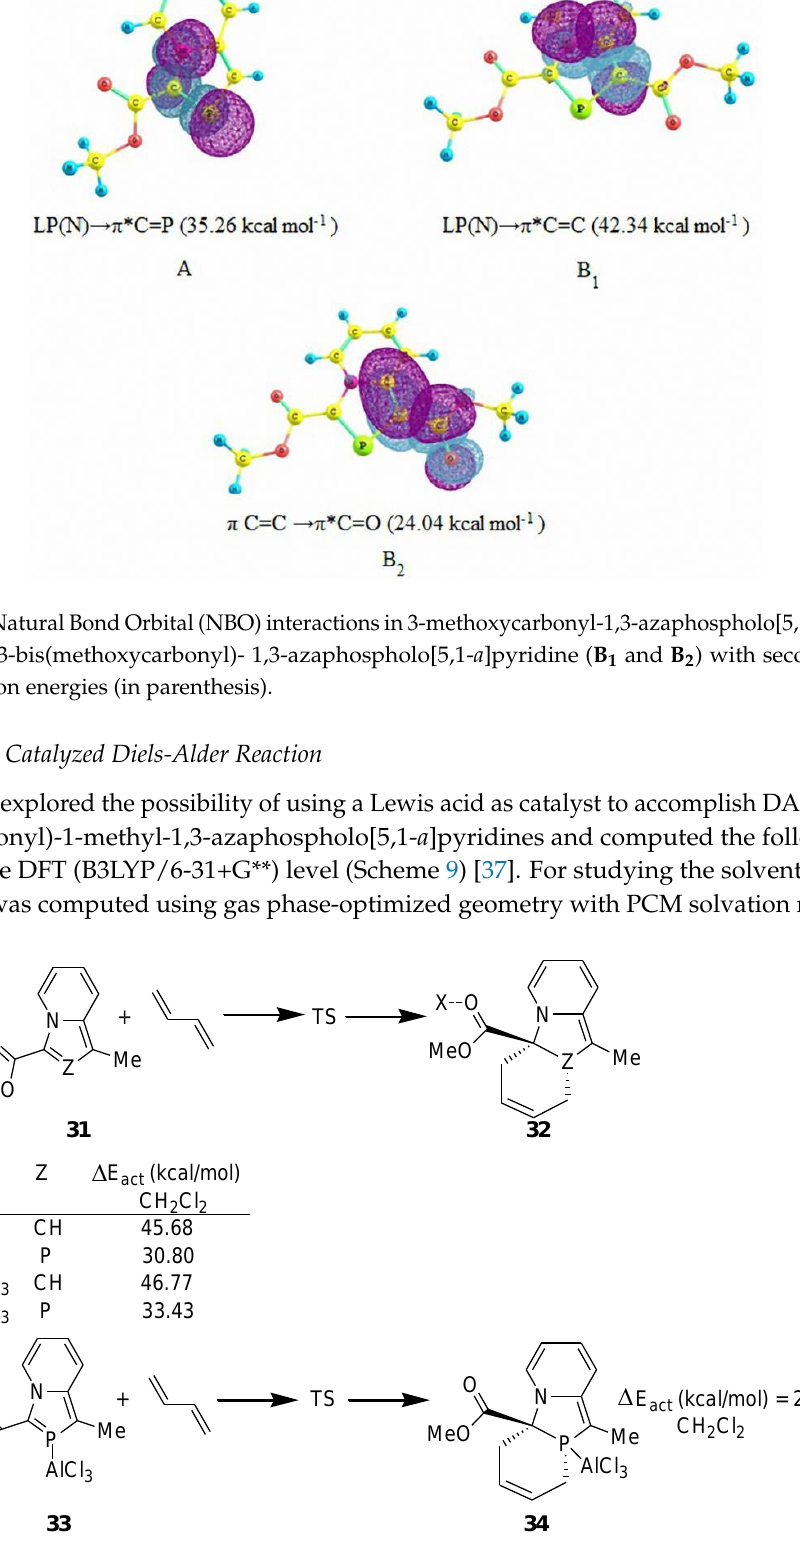
Scheme 9. Model DA reactions computed at the B3LYP/6-31+G** level.